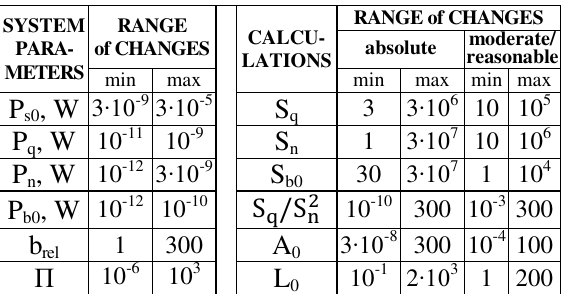
Table 1. System parameters considered.